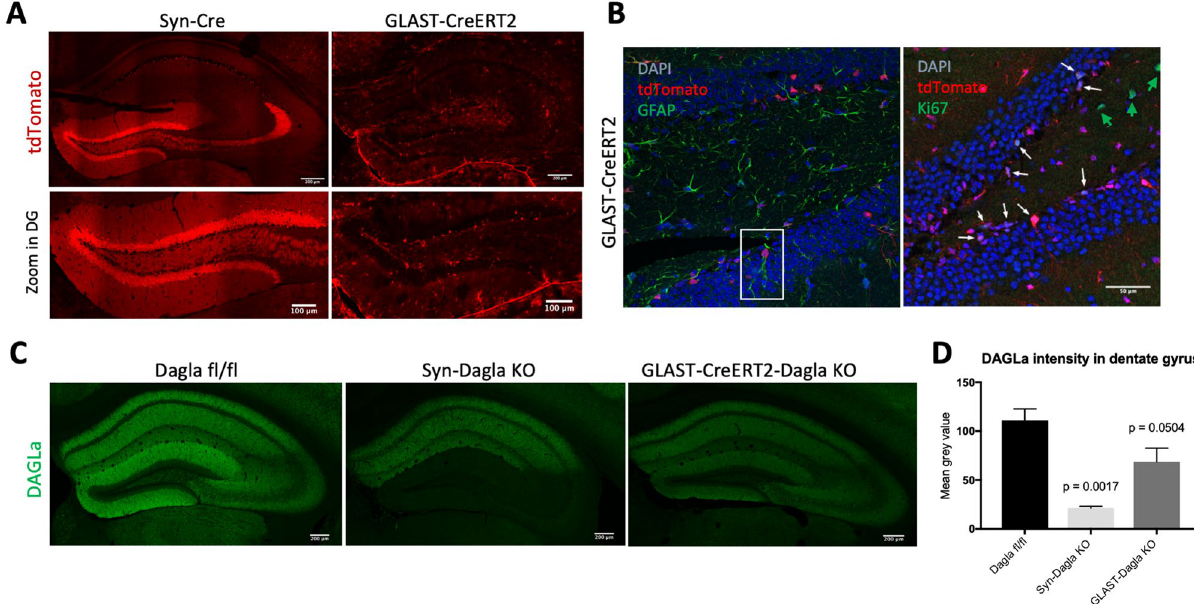
Figure 2. Syn-Dagla KO and GLAST-CreERT2-Dagla KO lines show opposing patterns of DAGLa deletion in the hippocampal dentate gyrus (DG). ( A ) Validation of Cre-efficacy in hippocampus (top, scale bar 200 µm) and DG (bottom, scale bar: 100 µm) in Syn-Cre and tamoxifen-induced GLAST-CreERT2 lines crossed with the RosaTomato reporter line. GLAST-CreERT2 show tdTomato expression (red) and thus recombination activity in areas populated mostly by glial cells, especially in the subgranular zone (SGZ) of DG, but not in neurons in the granule cell layer of DG. Syn-Cre mice show tdTomato expression specifically in neurons in the granule cell layer of DG and CA3 but not in CA1 and CA2 or SGZ. ( B ) (Left) Co-staining of GLAST-CreERT2-RosaTomato with glial marker GFAP (green) in dentate gyrus. TdTomato expressing glia cells are mainly localized in the subgranular zone (SGZ) of dentate gyrus and show typical shape of neural stem and progenitor cells (NSPCs, example in white box)). Only few astrocytes not located in SGZ show tdTomato expression. (Right) Co-staining of GLAST-CreERT2-RosaTomato with proliferation marker Ki67 (green). 68% of all proliferating cells express Cre; 17% of all Cre-expressing cells are proliferating cells (n = 3 animals/group; white arrows: cells co-expressing tdTomato and Ki67; green arrow: proliferating cells not expressing tdTomato). ( C ) Representative images of DAGLa immunostainings from hippocampi. In Dagla fl/fl control mice, DAGLa is highly expressed throughout the hippocampus. Syn-Dagla KO mice show a very low DAGLa signal in dentate gyrus (DG) and cornu ammonis 3 (CA3), while CA1 and CA2 show similar DAGLa expression as in Dagla fl/fl control mice. The DAGLa signal in hippocampus of GLAST-CreERT2-Dagla KO mice is markedly reduced compared to control mice. ( D ) Quantification of DAGLa signal intensity in the DG of conditional knockout mice. GLAST-CreERT2- Dagla KO mice show a significant reduction of DAGLa signal in the dentate gyrus, that was even more pronounced in Syn-Dagla KO mice (1-way ANOVA: F 2,6 = 18.34; p = 0.0028; n = 3 per